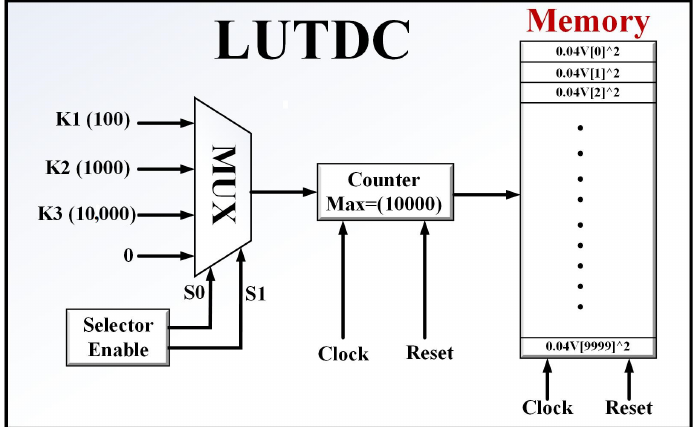
Figure 8. Look-Up Table presentation of the nonlinear part of the Izhikevich neuron model.